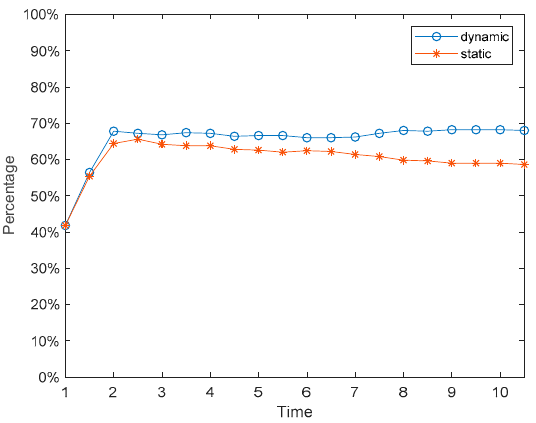
Int. J. Environ. Res. Public Health 2020 , 17 , 946 Figure 22. Individual attitude distributions at different times. Figure 22. Individual attitude distributions at di ff erent times.